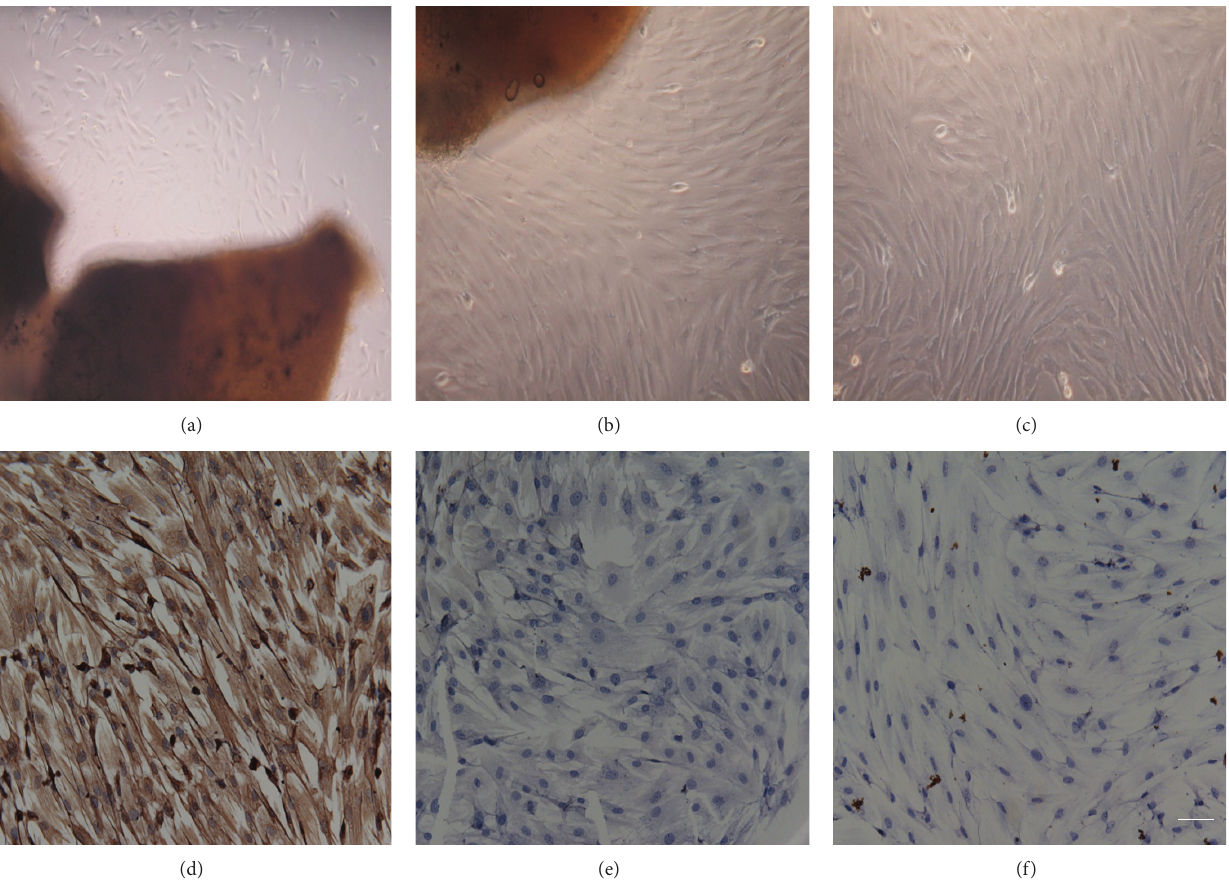
Figure 3: Primary culture and identification of scleral fibroblasts in guinea pig. (a) At the third day, a small amount of fibroblasts climbed out from the scleral tissue. (b) At the sixth days, there were about 60% of fibroblasts. (c) At the fifth days at the second passage, cell fusion was about 80%–90%. (d) Cultured scleral fibroblasts were stained positive for vimentin. (e) In blank control group, the staining in cultured scleral fibroblasts was negative. (f) Cultured scleral fibroblasts were stained negative for keratin (original ∗ 200, bar = 50 𝜇